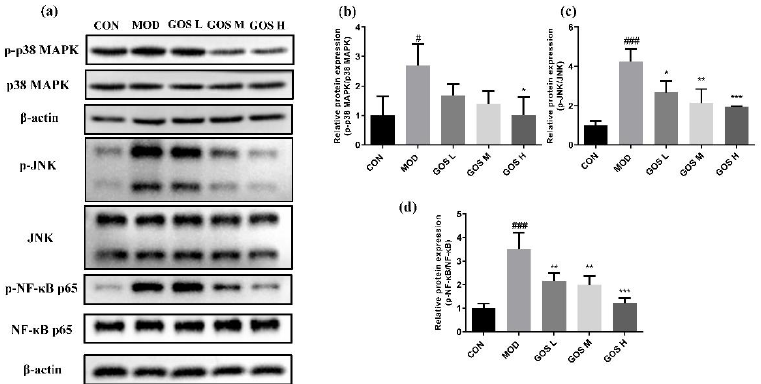
Figure 8. Effects of GOS on the NF- κB and MAPK pathways in L02 liver cells. ( a ) Western blot images of the NF- κB and MAPK pathways in L02 liver cells ( n = 3, means ± SD). ( b ) Phosphorylated protein expression levels of p38 MAPK ( n = 3, means ± SD). ( c ) Phosphorylated protein expression levels of JNK ( n = 3, means ± SD). ( d ) Phosphorylated protein expression levels of NF- κB p65 ( n = 3, means ± SD). Notes: Compared with the MOD group, * p < 0.05, ** p < 0.01, and *** p < 0.001; compared with the CON group, # p < 0.05, ### p < 0.001.